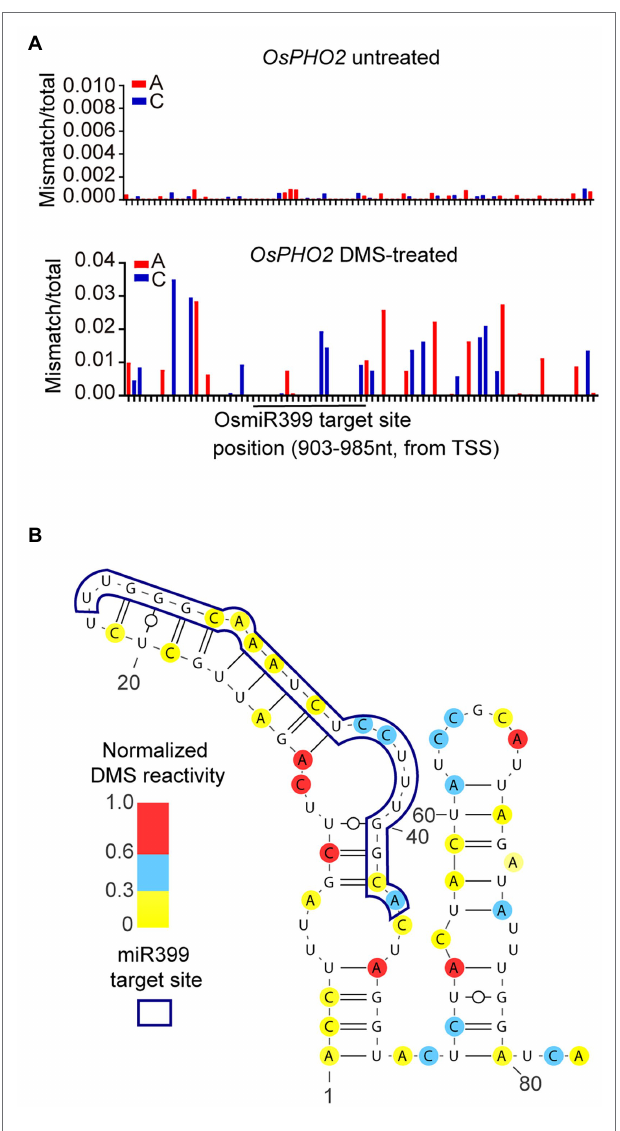
FIGURE 6 | Profiling RNA secondary structure of a OsmiR399 target site located at 5 ′ UTR of OsPHO2 . (A) Ratiometric DMS signals of each A and C were plotted along the tested 5 ′ UTR of OsPHO2 . The OsmiR399 target site was shown by a black line. (B) The RNA secondary structure of an OsmiR399 target site located at 5 ′ UTR of OsPHO2 was predicted based on our DMS- MaPseq data. The ratiometric DMS signal per position normalized to the highest mismatch/total in the displayed region, which was set arbitrarily to